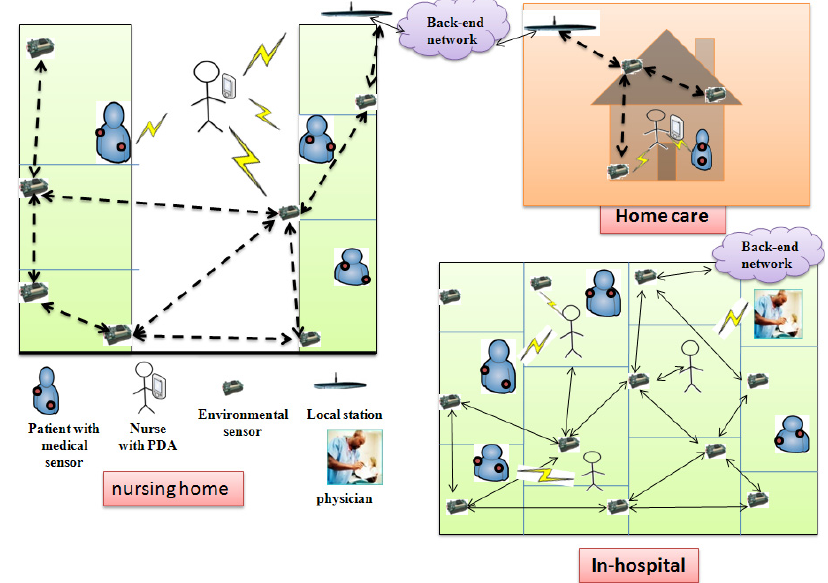
Figure 8. Application scenarios for a nursing home, home care, and